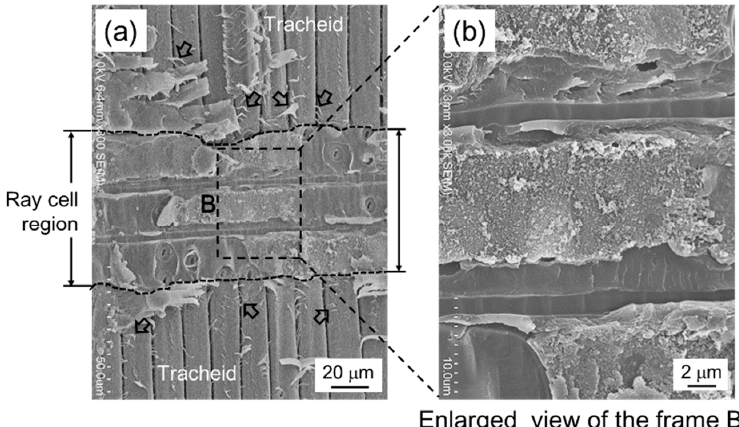
Figure 14. Microfractography of the shear fracture behavior along the tracheid interface and intercellular layer into the ray tissue.